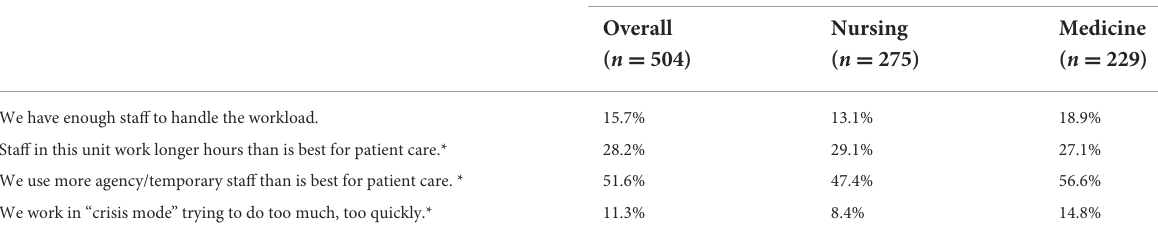
TABLE 2 Percent positive scores of staffing items overall and divided by profession. Staffing items